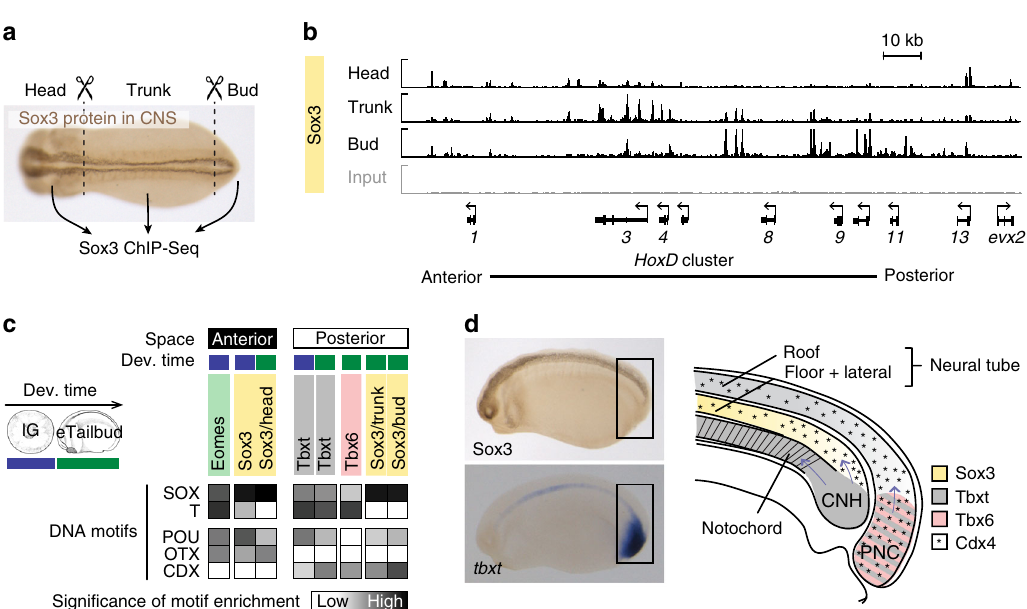
Fig. 5 Pro fi ling chromatin for Sox3 in different anterior – posterior compartments of the central nervous system (CNS). a Experimental design: Genome-wide Sox3 pro fi ling of head, trunk and bud dissected from early tailbud embryos after tissue fi xation. b Snapshot of Sox3 binding to HoxD cluster in the head, trunk and bud. Note the differential binding of Sox3 with ‘ anterior ’ , ‘ middle ’ and ‘ posterior ’ Hox genes being preferentially occupied in head, trunk and bud, respectively. c Heat map shows the signi fi cance of DNA motif enrichments ( y -axis) across 10,000 pCRMs most frequently occupied in each chromatin pro fi le ( x -axis). Pro fi les are grouped depending on whether the cells expressing the TF of interest preferentially contribute to the anterior or posterior compartment. Abbreviations used for the developmental timeline: lG, late gastrula; and eTailbud, early tailbud. d Anatomical map of TF expression at the posterior end of an early tailbud embryo to explain the co-enrichment of ‘ posterior ’ TF-speci fi c DNA recognition motifs in c . Sox3-expressing cells of the posterior neural tube originate from the chordoneural hinge (CNH) and posterior wall of the neurenteric canal (PNC) expressing Brachyury and Brachyury/ Tbx6, respectively 21 . Both neural tube and PNC are also exposed to the expression of Cdx such as Cdx4